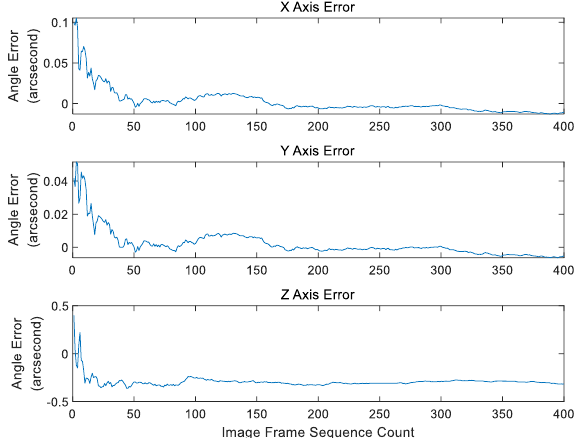
σ σ    (pixel). Figure 5. Deviation angle error(arc-second) estimation with frame in s = 0.06, c = 0.1 s c